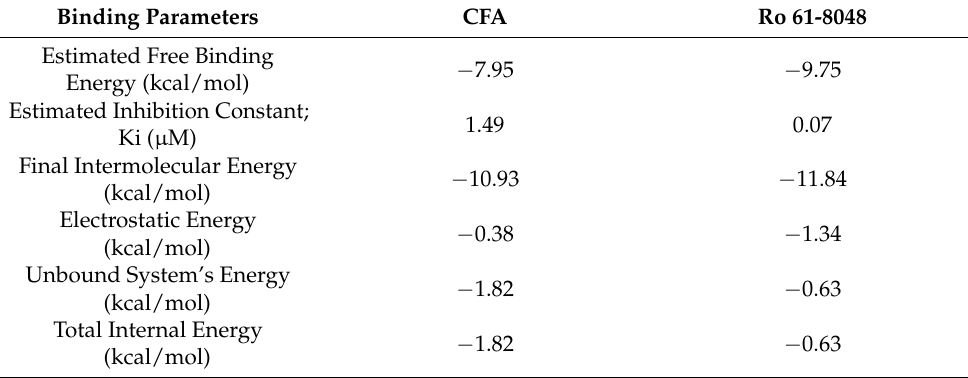
Table 3. Molecular docking binding parameters of CFA and Ro 61-8084 with the KMO protein. Binding Parameters